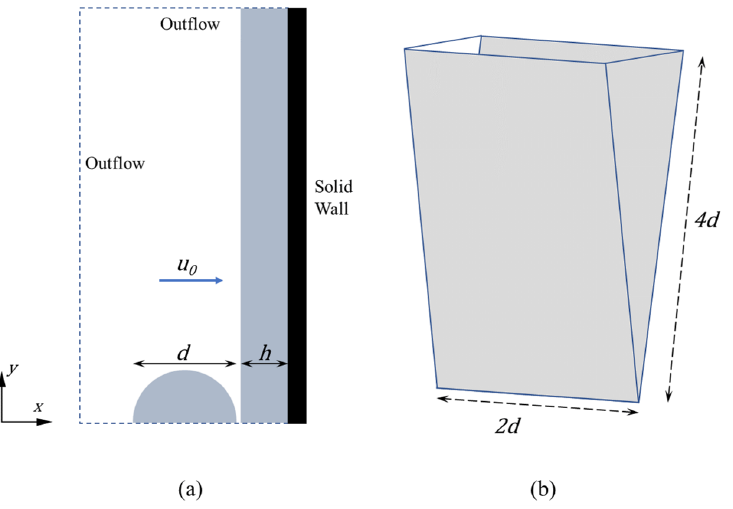
Figure 9. Initial configuration and boundary conditions ( a ) with computational domain ( b